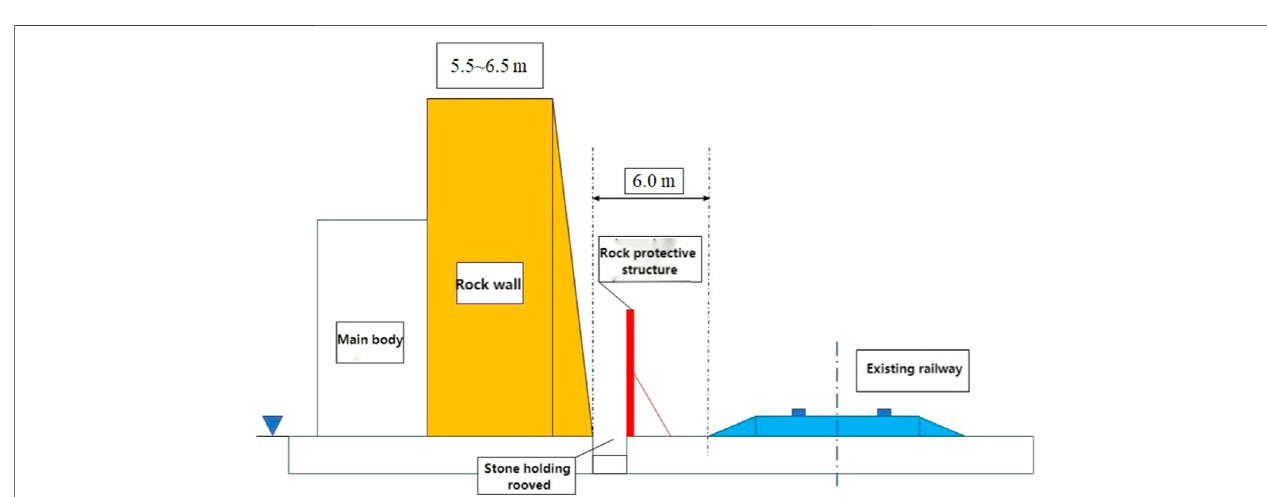
FIGURE 6 | Excavation pro fi le